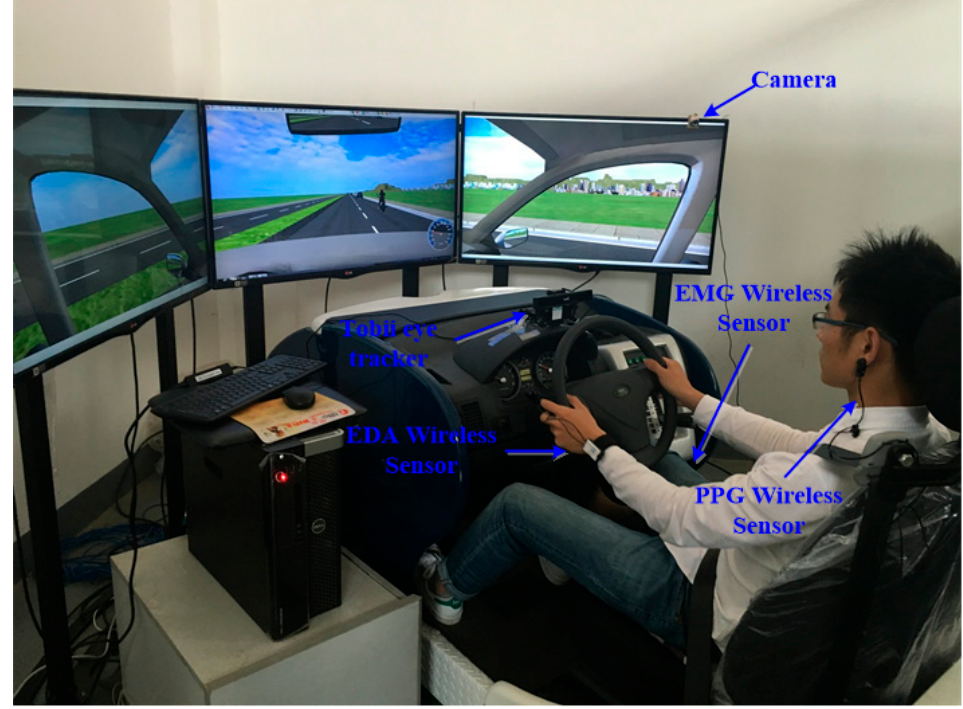
Figure 1. Participant in the simulator with sensors.